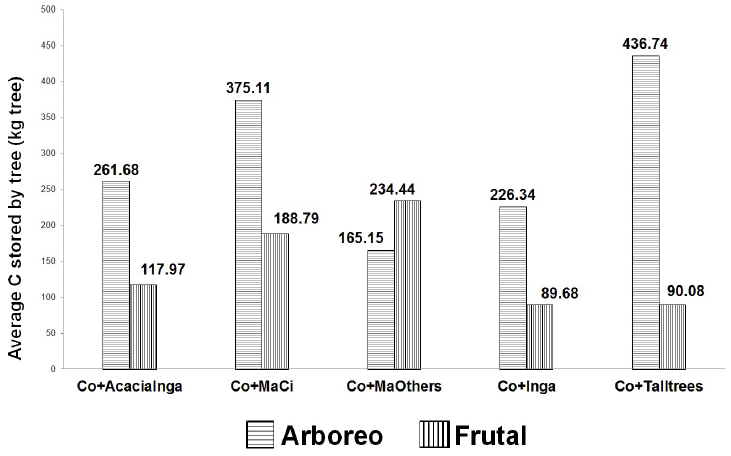
Figure 3. Average C stored by tree (kg tree − 1 ) by stratum and type of coffee